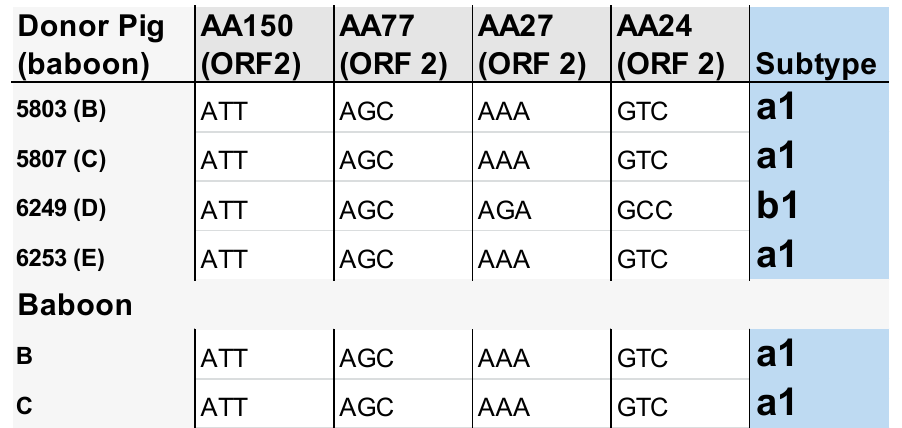
Figure 3. Determination of the subtype of PCV3 in the donor pigs and recipient baboons. No PCV3-positive DNA was available from baboons D and E to perform sequencing. AA, amino acids, ORF 2, open reading frame 2 of PCV3.